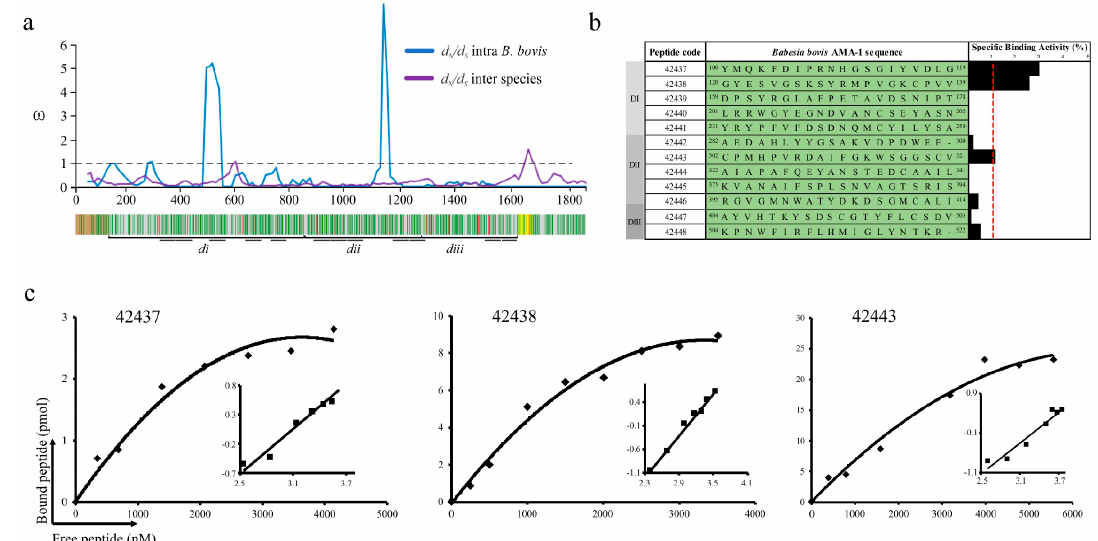
Figure 1. B. bovis AMA-1 peptide selection and binding to bovine erythrocytes. ( a ) The sliding window showing the ω rate ( y -axis) and the nucleotide position ( x -axis) (A ω < 1 means functional constraint). A gene diagram indicating the B. bovis AMA-1 encoding regions for the signal peptide (brown), the transmembrane region (yellow) and DI (di), DII (dii) and DIII (diii) can be observed below the sliding window. Negatively selected inter-species codons are shown in green and positively selected ones in red. ( b ) Binding profile for B. bovis AMA-1 domain-derived highly conserved peptides, carried out in triplicate. Cell binding activity percentage is represented by black bars. The binding activity (red line) was considered when each peptide had ≥ 1 binding percentage. ( c ) Peptide saturation curves. Log F = free peptide ( x -axis) and log [B/bmax-B] ( y -axis), where B = amount of bound peptide and Bmax = maximum amount of bound peptide, shown on the Hill plot (inset).